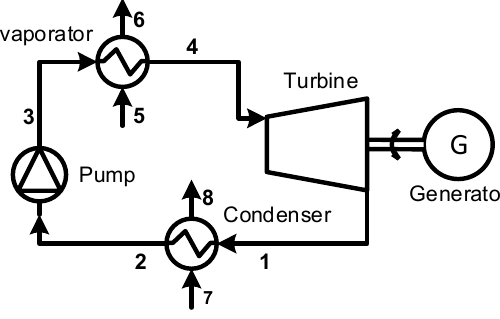
Figure 1. Component layout trans- and subcritical organic Rankine cycle (ORC).